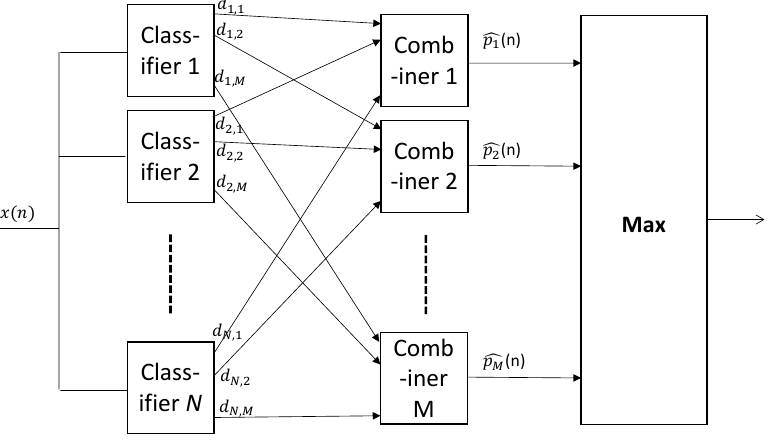
Figure 5. Block diagram of the multi-class combining